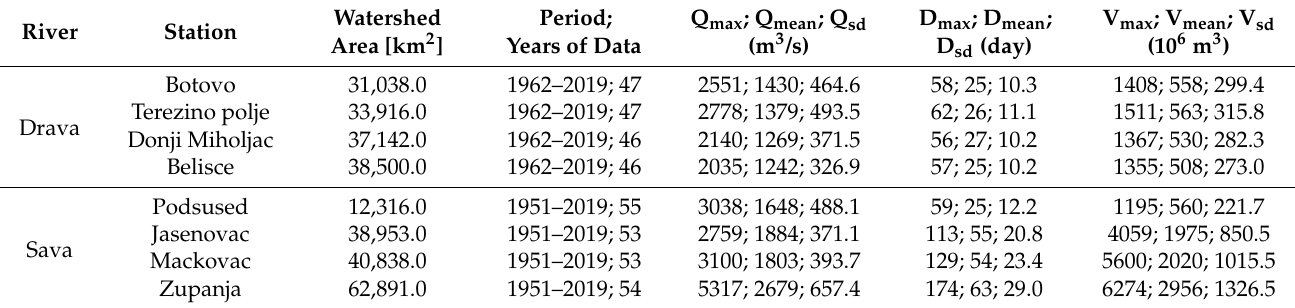
Table 1. Basic properties of the observed annual maximum series of hydrological variables: peak discharge (maximum—Q max ; mean—Q mean and standard deviation—Q sd ), hydrograph du- ration (maximum—D max ; mean—D mean and standard deviation—D sd ) and hydrograph volume (maximum—V max ; mean—V mean and standard deviation—V sd ) for gauging stations on the Drava and Sava